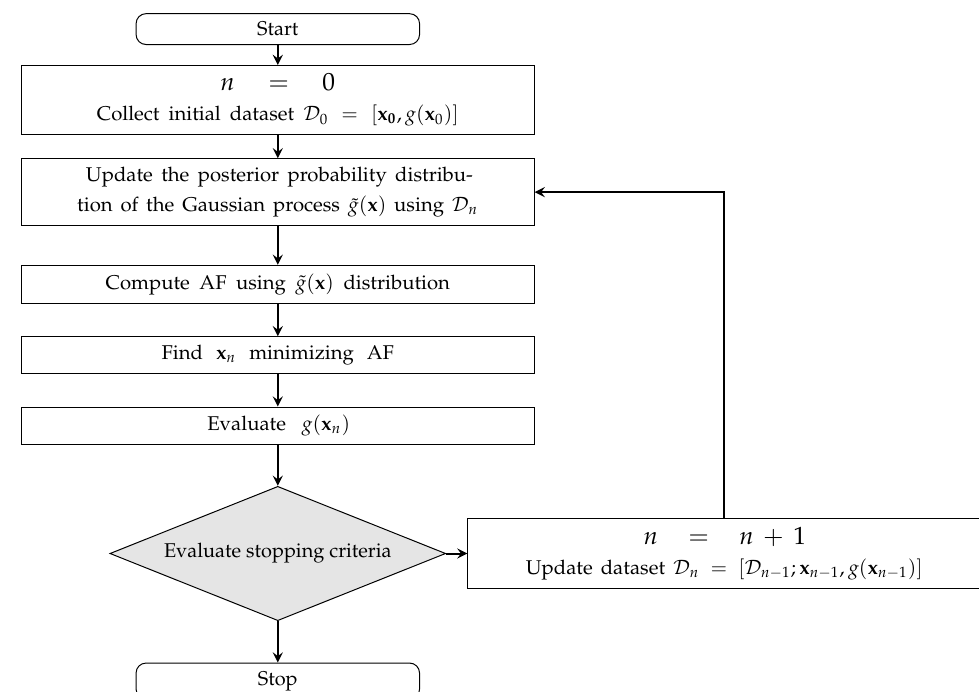
Figure 6. Flow chart for single-objective Bayesian